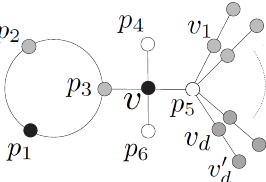
Fig. 3: The auxiliary graph D ( v ) . This graph has 7 + 10 k (cid:100) 3 ε (cid:101) +1 vertices, where d = 5 k (cid:100) 3 ε (cid:101) +1